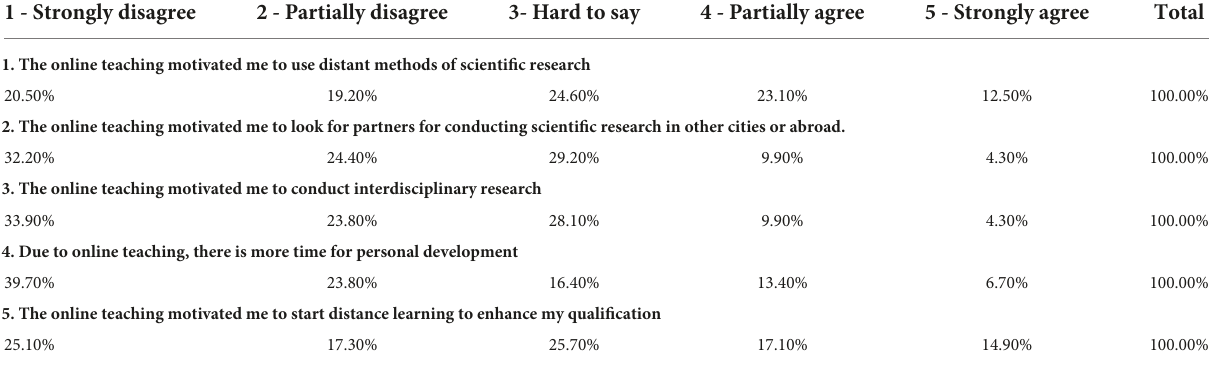
TABLE 3 Indicators of motivation for research and personal development due to the COVID-19 epidemic. 1 - Strongly